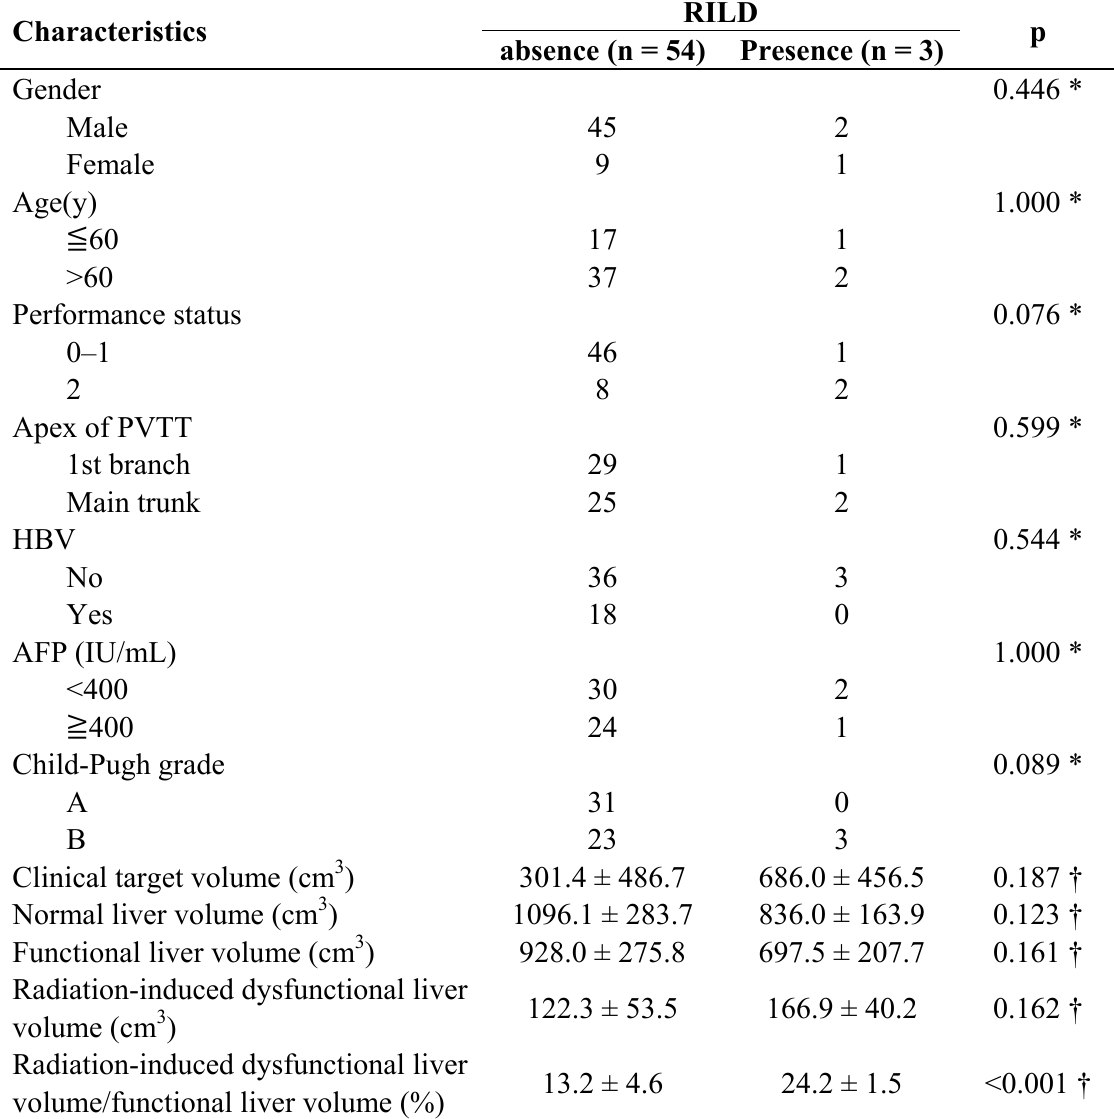
Table 3. Comparison of backgrounds and RT characteristics in the patients between with radiation-induced liver disease (RILD) and